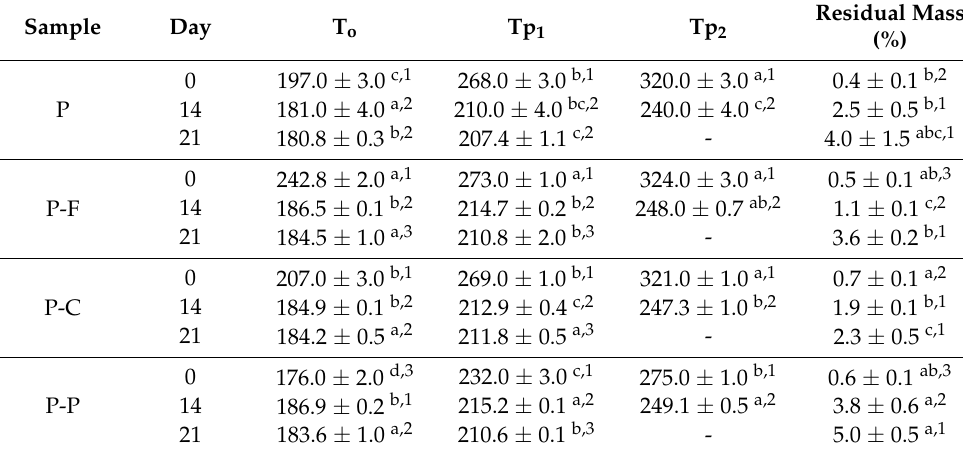
Table 3. TGA parameters obtained from the TGA throughout the composting process: onset (To) and peak (Tp) temperatures, and pyrolysis residual mass at 600 ◦ C of PLA-PHBV blend films (P) and PLA-PHBV blend films containing ferulic acid (P-F), p -coumaric acid (P-C) and protocatechuic acid (P-P). Mean values and standard